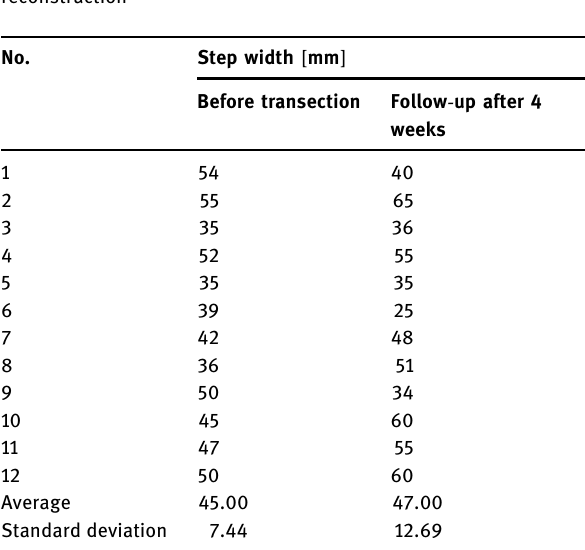
Table 2: The width of the steps ( the distance between the hind paws ) before the transection of the nerves and 4 weeks after